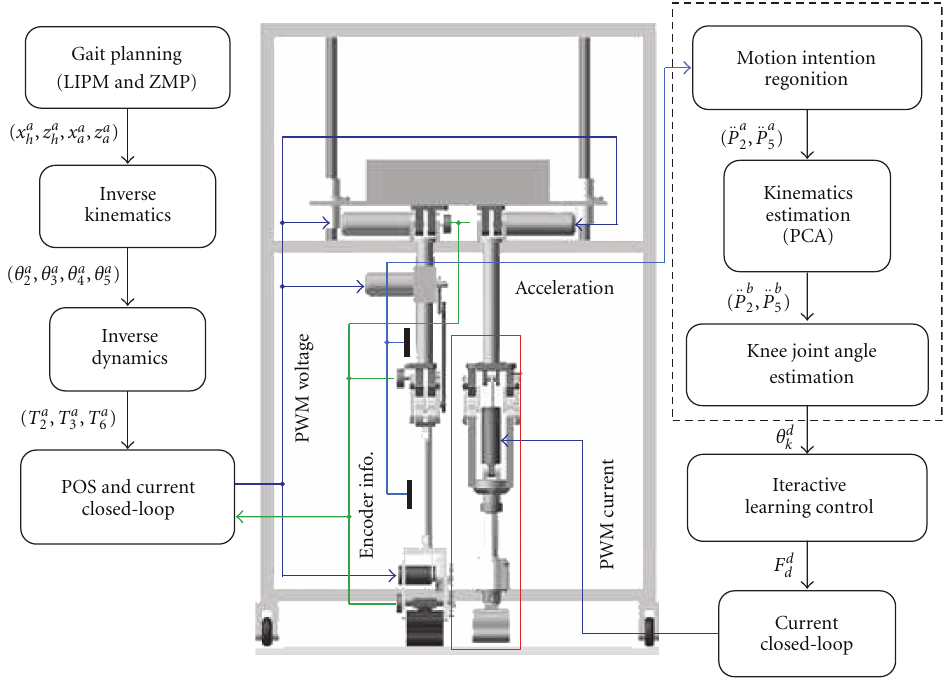
Figure 2: Coordinated control